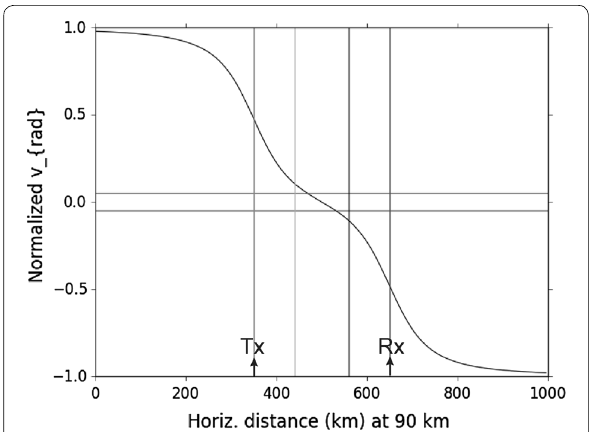
Fig. 5 Doppler-shifted velocity components measured by the radar as a function of horizontal displacement at 90 km range, for a transmitter at x 350 km and a receiver at x 650 km. The speeds are = = normalized by division by the true horizontal velocity, so approach unity at the edges. The radar-measured parameter is referred to as v rad , by analogy with the backscatter case, but it is not truly a radial velocity. Lines are drawn horizontally near the zero-point on the abscissa—values within these lines will have measured speeds less than 0.05 of times the true horizontal speed, making inversion of the data difficult and potentially